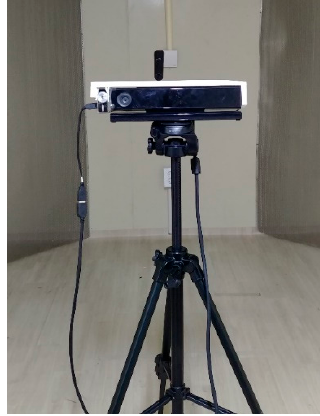
Figure 4. Infrared (IR) camera used in the experiments.